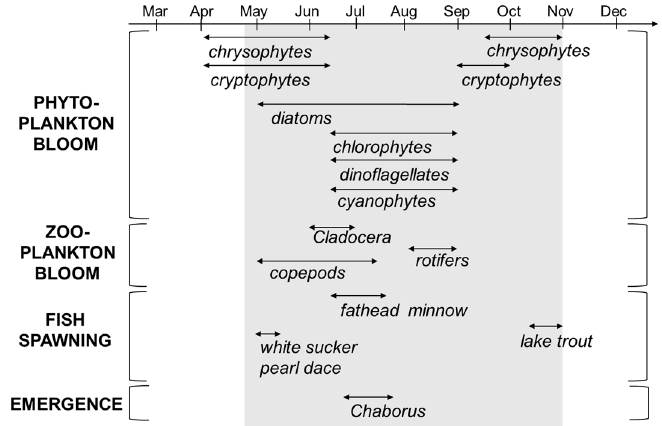
Figure 2. Seasonal cycles of the selected species based on expert knowledge (grey = experimental data collected during the open water season).